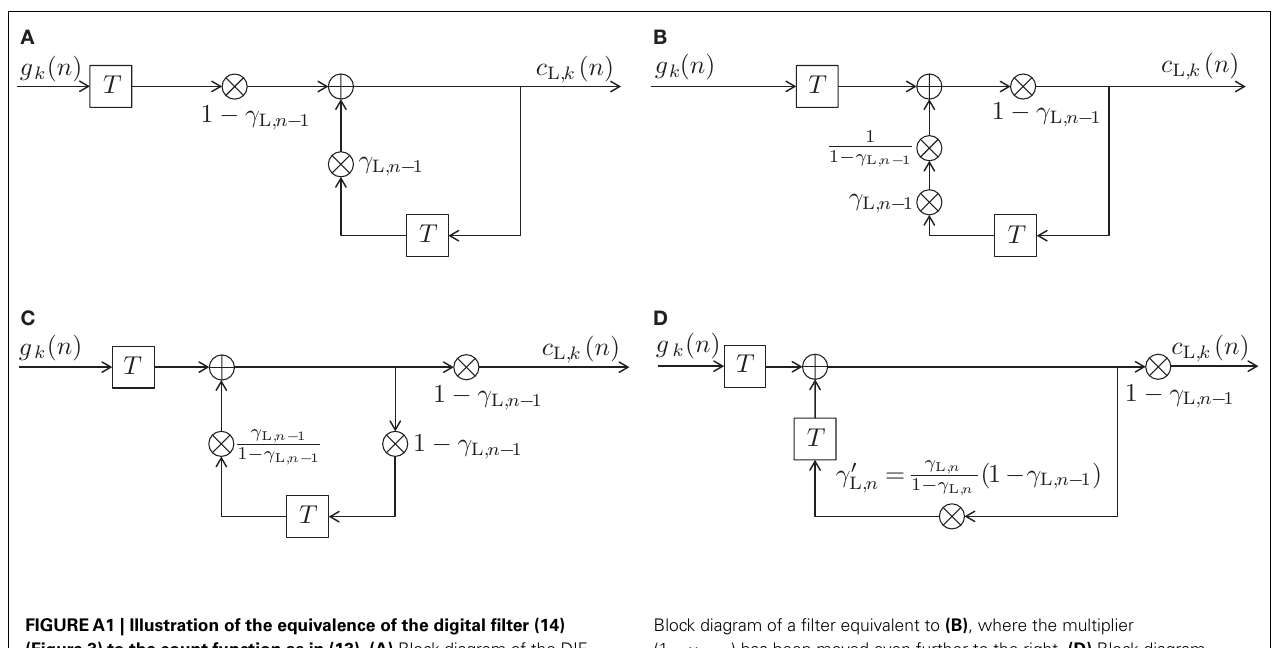
Block diagram of a filter equivalent to (B) , where the multiplier (1 − γ L, n − 1 ) has been moved even further to the right. (D) Block diagram of a filter equivalent to (C) , where the multiplier γ L, n − 1 /(1 − γ L, n − 1 ) has been moved to the right of the delay unit in the lower